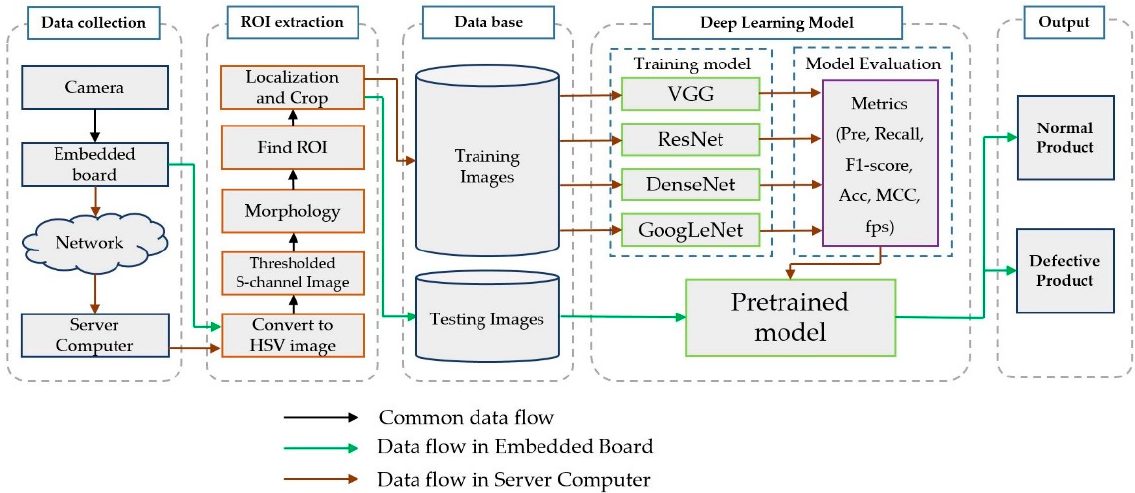
Figure 3. The framework of proposed method.